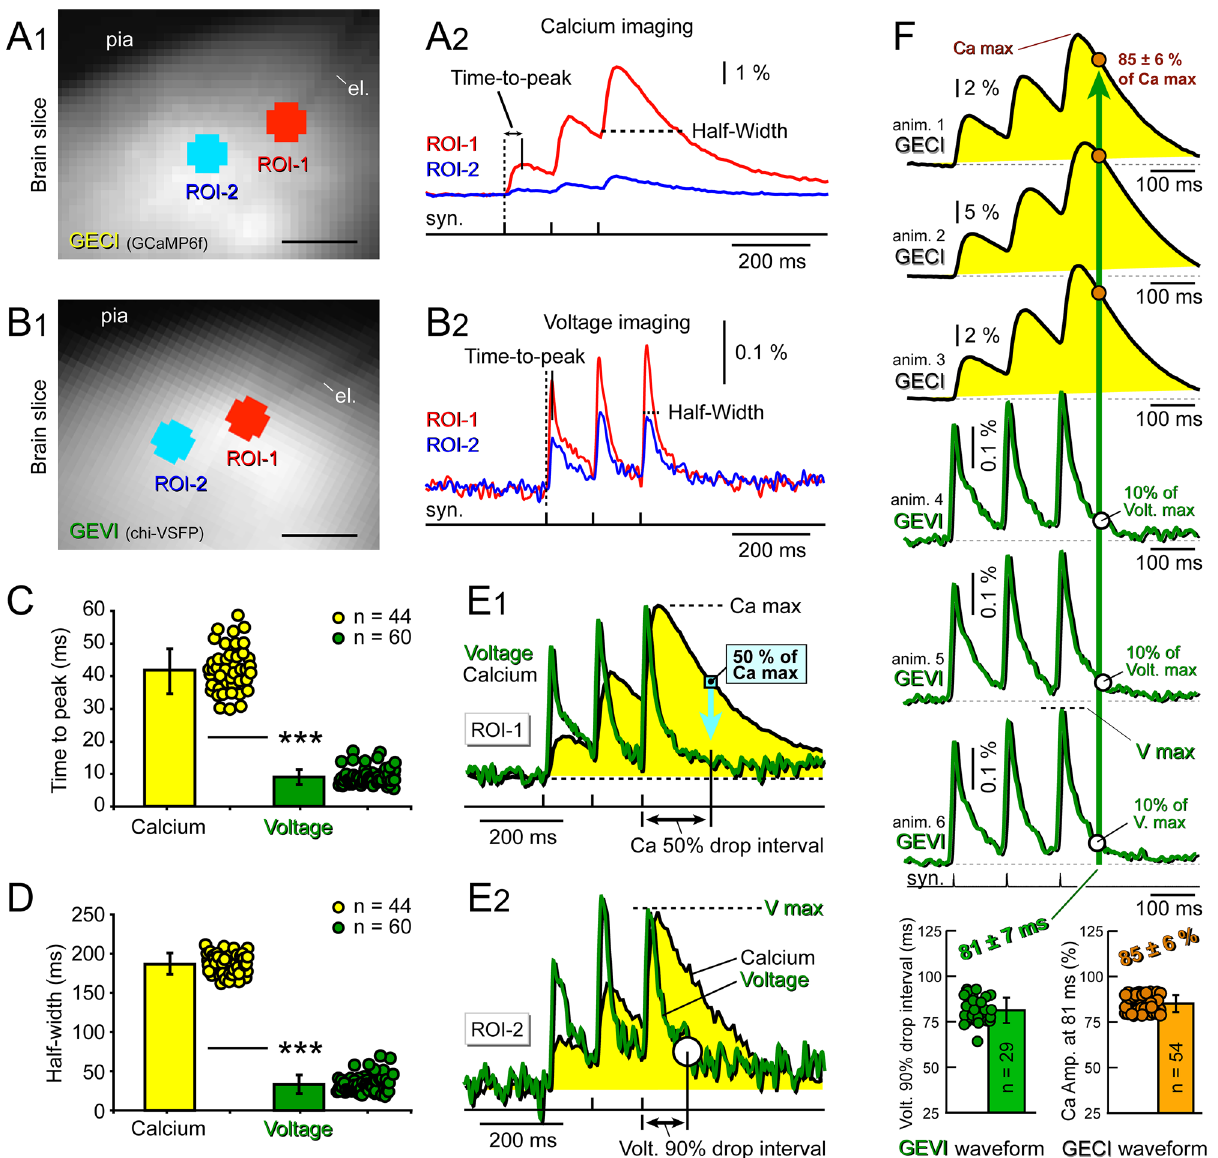
Figure 2. Onset, duration and decay—calcium (GECI) versus voltage (GEVI) optical signals. ( A1 ) Transgenic animal expressing GECI (GCaMP6f) in cortical pyramidal neurons. Coronal brain slice imaged by NeuroCCD 80 × 80 pixel. Scale, 200 µm. Two ROIs are selected, at the stimulation site (ROI-1), and 200 µm away from the stimulation site (ROI-2). ( A2 ) Synaptically-evoked optical signals in GECI mouse. Time-to-peak parameter is measured between stimulus pulse and calcium signal peak. Signal duration is measured in the 3rd peak at half amplitude ( Half-Width ). ( B1 ) Same as ( A1 ), except the transgenic animal is expressing GEVI (chi-VSFP). ( B2 ) Same as in ( A2 ), except GEVI mouse. ( C ) Each dot represents one measurement (one experimental trial) of the time-to-peak parameter quantified at the stimulation site (ROI-1). Calcium: 44 trials, in 6 brain slices from 3 animals. Voltage: 60 trials, in 13 slices, of 7 animals. ***, p < 0.0001. ( D ) Same as in ( C ), except different parameter, half-width. ( E1 ) Calcium (black) and voltage (green) optical signals are superimposed on the same time scale. Ca signal decreases 50% in time interval marked by double arrow. Vertical turquois line marks the time point “144.5 ± 10.5 ms”, when, on average, Ca signal amplitudes dropped down to 50% of their maxima. At that moment of time, “144.5 ± 10.5 ms”, Ca signal is at 50%, while the voltage trace is near the baseline (0–5%). ( E2 ) Same as in ( E1 ), except different ROI (away from the stimulation site, ROI-2). Voltage signal decreases by 90% in time interval marked by double arrow. ( F ) Three optical signals from 3 GECI animals, followed by 3 optical signals from 3 GEVI animals. Optical signals are aligned by synaptic stimulation pulses (syn.). Bottom: Green data points: time intervals (from the synaptic stimulus) at which voltage signals dropped down to 10% of their maxima ( V max ). The average time delay for this 90% descent was 81 ± 7 ms (n = 29). Vertical green arrow marks the time point “81 ± 7 ms” transecting voltage and calcium waveforms. Bottom, orange points: Ca signal amplitudes measured 81 ms after the syn. pulse; normalized to the “ Ca max ” of the same trace; 85 ± 6% (n = 54). The voltage had dropped down to 10%, while the calcium is still lingering at ~